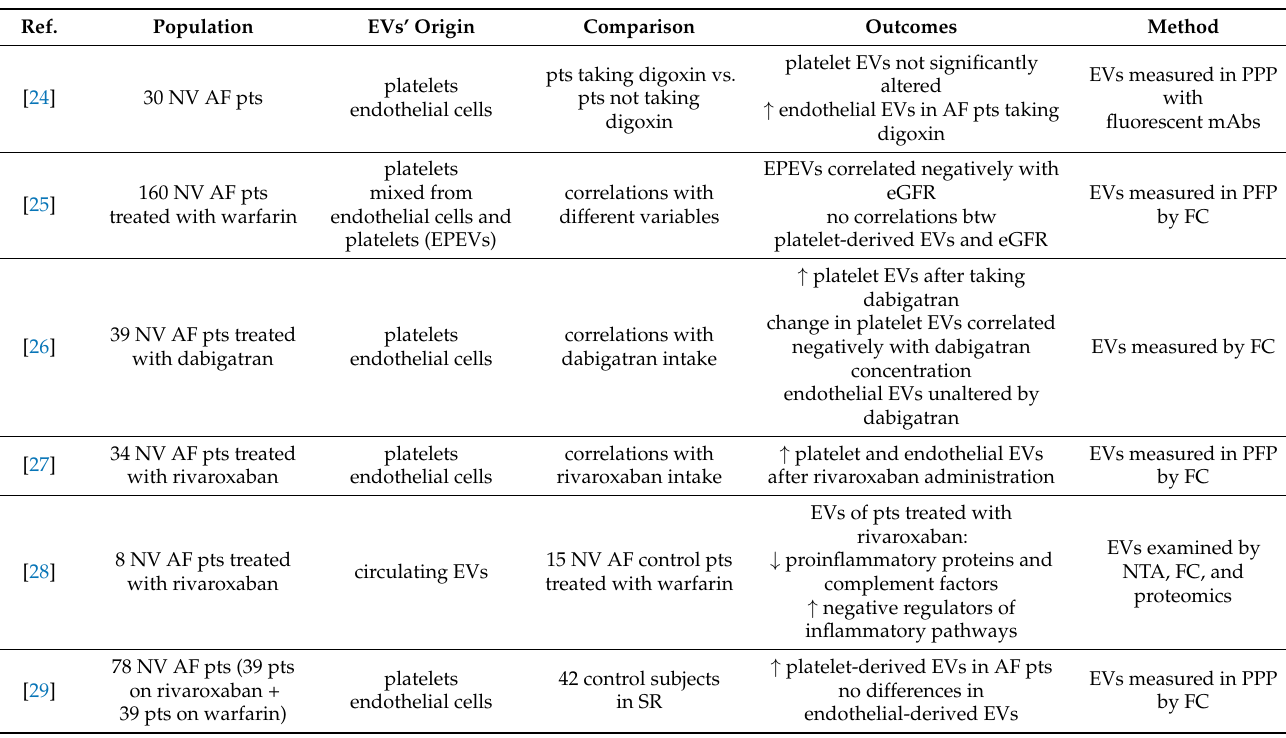
Table 1. The summary of recent studies regarding extracellular vesicles in atrial fibrillation patients treated with anticoagulants and other